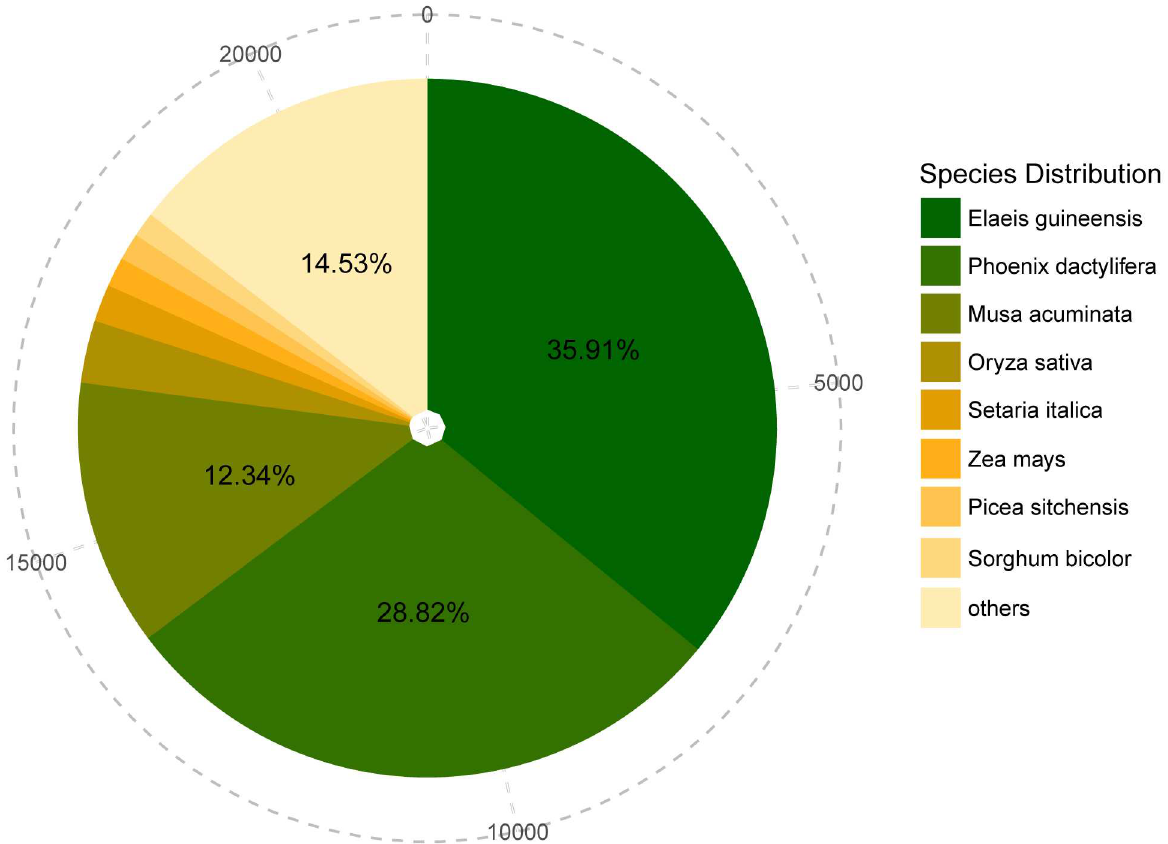
Fig 1. Species distribution of best blastx hits to NR database. Cumulative total numbers of unigenes annotatedto NR are shown in the outermost circle with the dotted line. The size of the area isin proportion to the percentage of best blastx hits to the corresponding